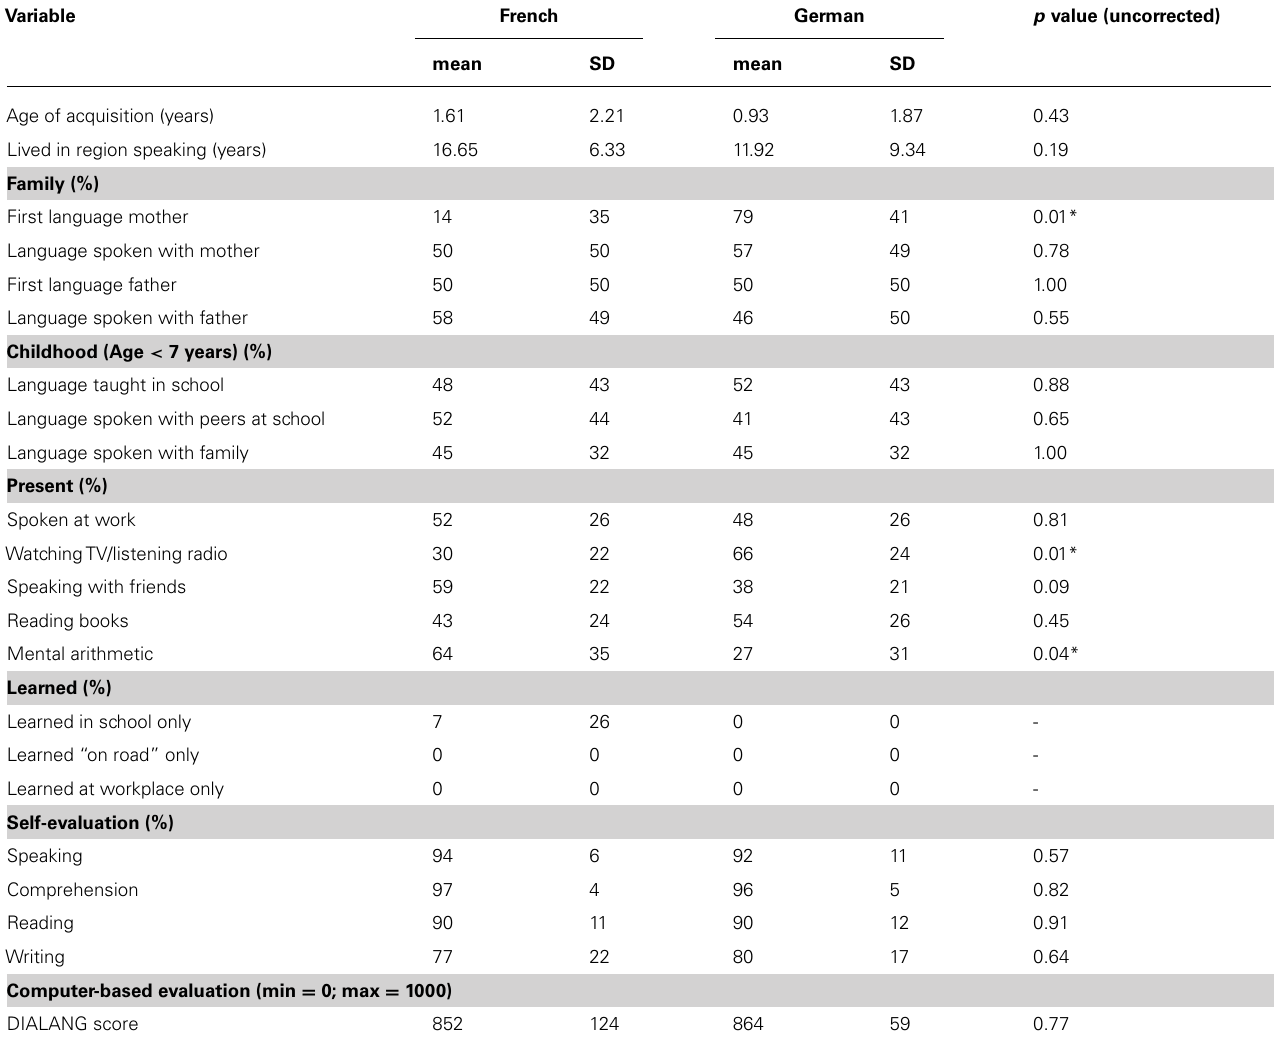
Table 1 | French-German bilingualism characteristics of participants ( N = 14).